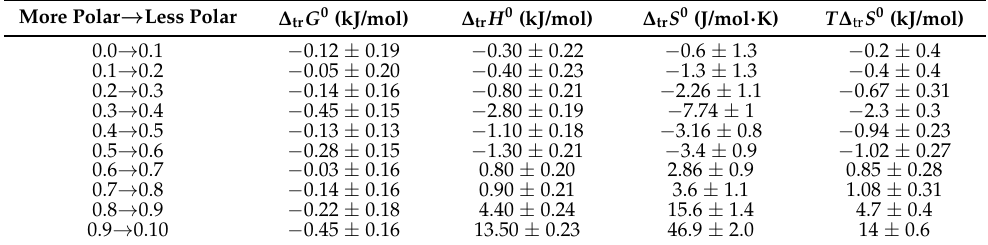
Table 6. Thermodynamic functions of transfer of isoniazid (3) in (PEG 200 (1) + water (2)) cosolvent mixtures at 297.6 K and a pressure p = 0.096